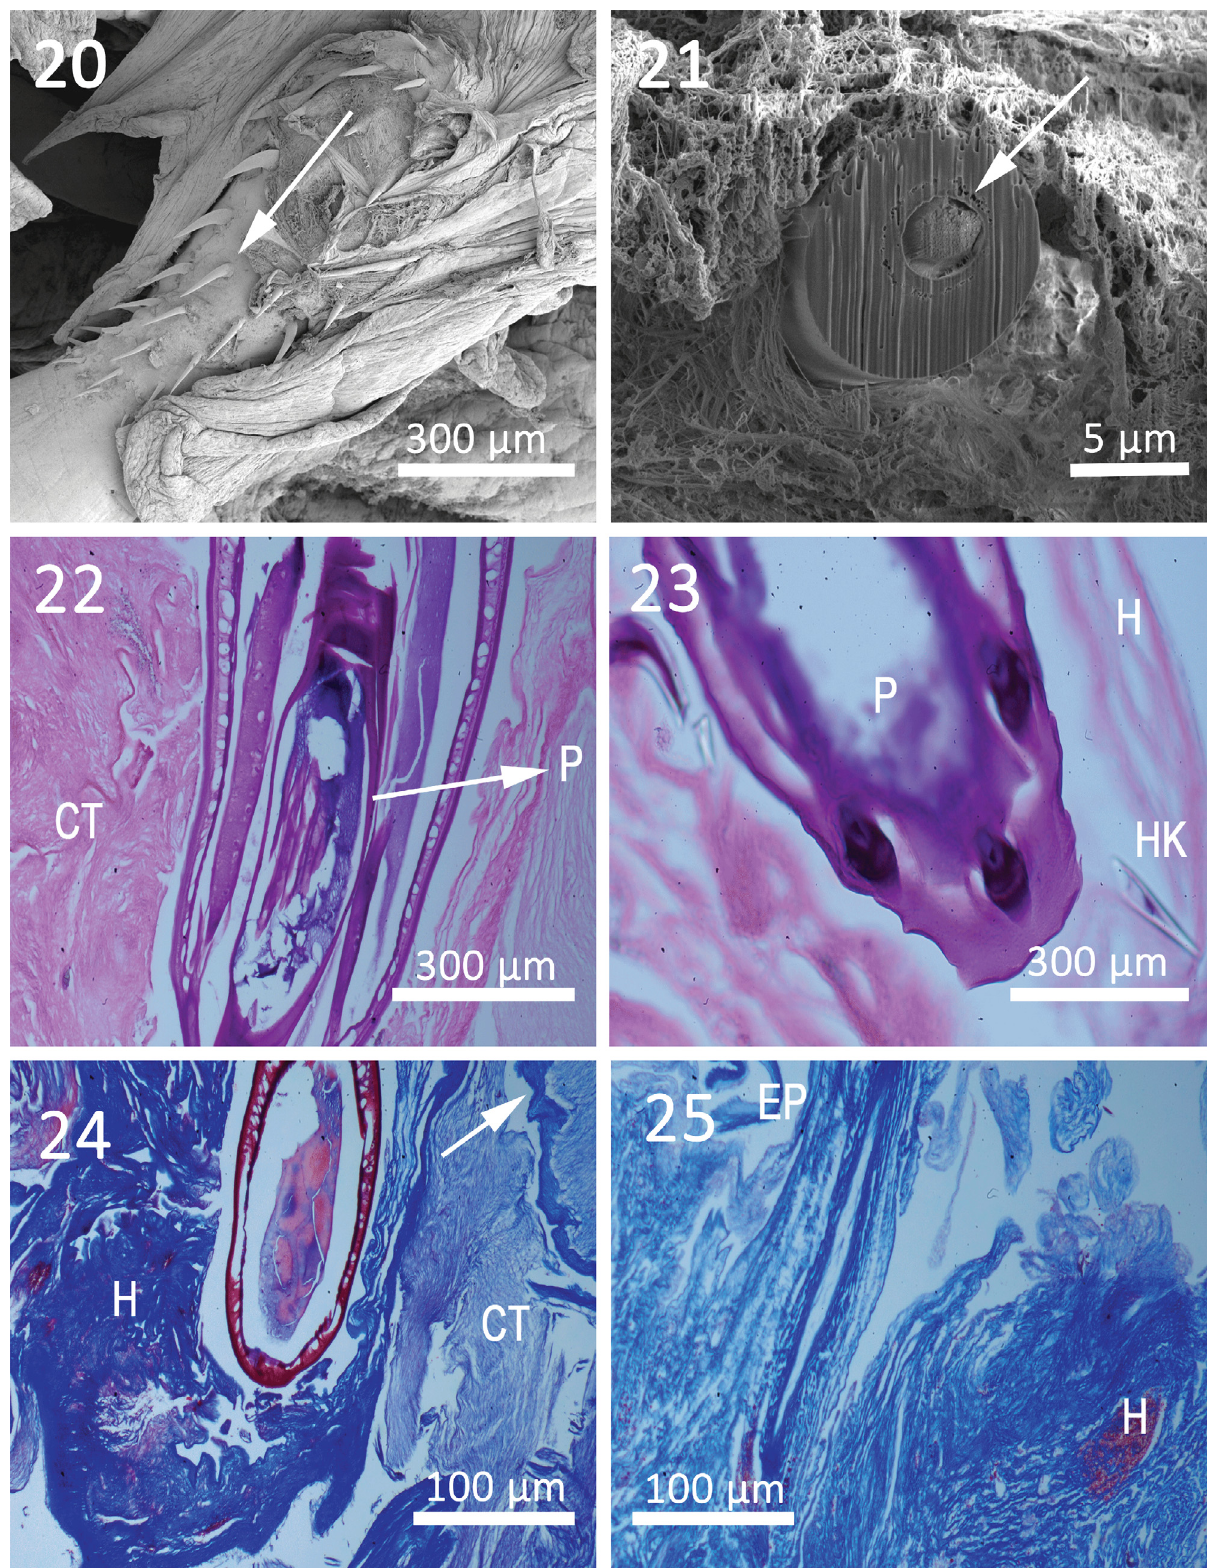
Figures 20-25. Histopathology of Cavisoma magnum in the intestinal track of Mugil cephalus from the Arabian Gulf. 20. SEM of attached worm; note hooks (arrow) on the proboscis of a worm. This image shows the gross pathology and the extreme damage to host intestinal tissue. 21. Gallium-cut hook (arrow) from proboscis of attached worm. Note host connective tissue surrounding worm. 22. Proboscis(P)ofa worm. Hostconnective tissue(CT) isvisiblewithremnants ofthe intestinalepithelium nexttothe worm. 23. Proboscis (P)of a wormwith sections of wormhooks(HK) andhost tissue (H)surrounding worm. 24. Trichromepreparationof infected host tissue (H) section and worm body are visible. Note remnants of host intestine (arrow). 25. Area where worm had infected the host tissue (H). Note ports of hemorrhaged blood caused by worm penetration and remnants of the host intestinal epithelium